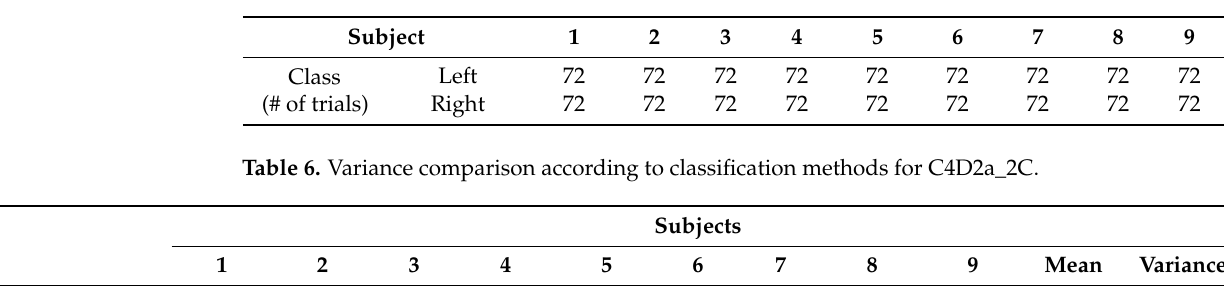
Table 5. The C4D2a_2C dataset composed of nine subjects and the predefined number of experimental trials.